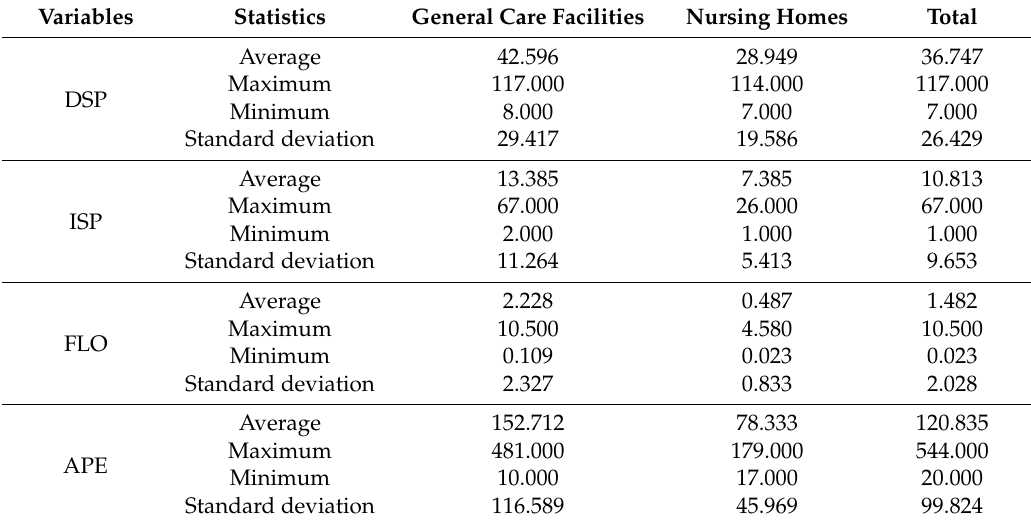
Table 2. Summary statistics.